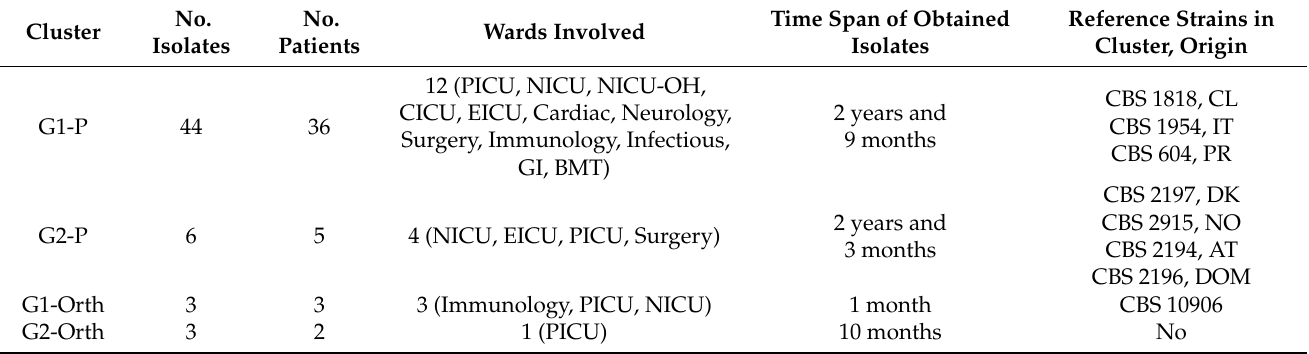
Table 1. Overview of the number and origin of C. parapsilosis complex isolates in each AFLP finger- print cluster (further details are provided in Supplementary Figure